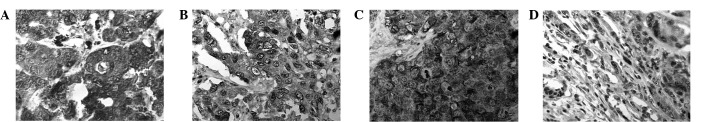
GSTP1 expression in breast cancer tissue. Section from breast carcinoma stained for GSTP1 by immunohistochemistry showing malignant cells with regions of expression and non-expression in the same tissue for GSTP1. (A) GSTP1 levels high, positive cancer cells, (B) GSTP1 levels low, positive cancer cells, (C) GSTP1-positive cancer cells and (D) GSTP1-negative cancer cells.